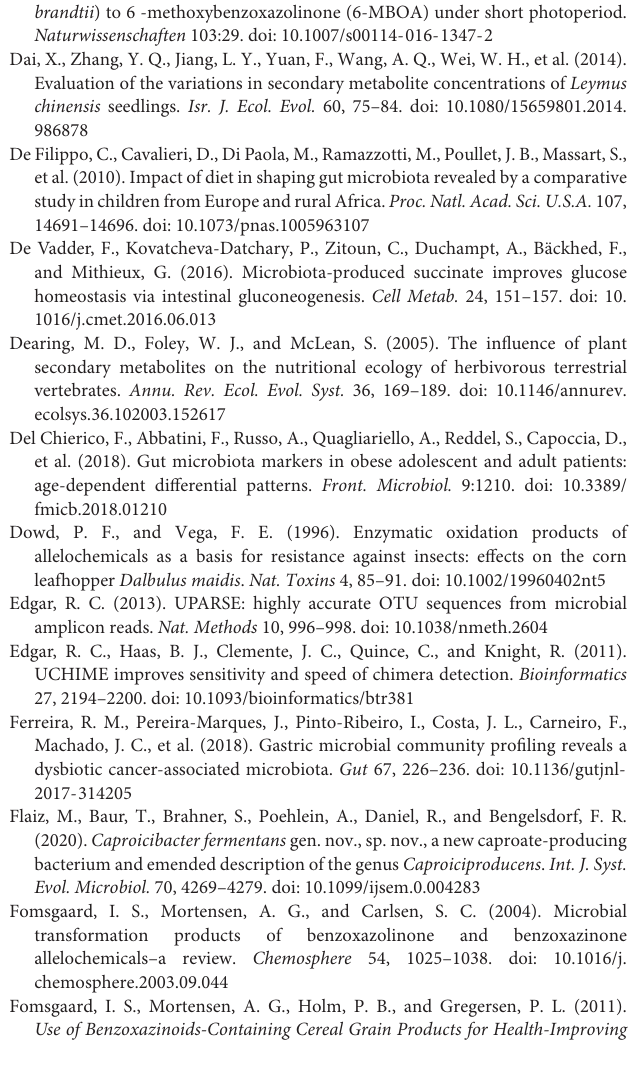
Supplementary Figure 3 | Relative abundance of operational taxonomic units among control group (0 mg/kg 6-MBOA), low 6-MBOA dose group (1 mg/kg 6-MBOA) and high 6-MBOA dose group (2 mg/kg 6-MBOA) at the family level in the cecal microbiota of adult male Brandt’s vole. Others mean the families with relative abundance less than 0.1%. Supplementary Figure 4 | Relative abundance of operational taxonomic units among control group (0 mg/kg 6-MBOA), low 6-MBOA dose group (1 mg/kg 6-MBOA) and high 6-MBOA dose group (2 mg/kg 6-MBOA) at the genus level in the cecal microbiota of adult male Brandt’s vole. Others mean the genera with relative abundance less than